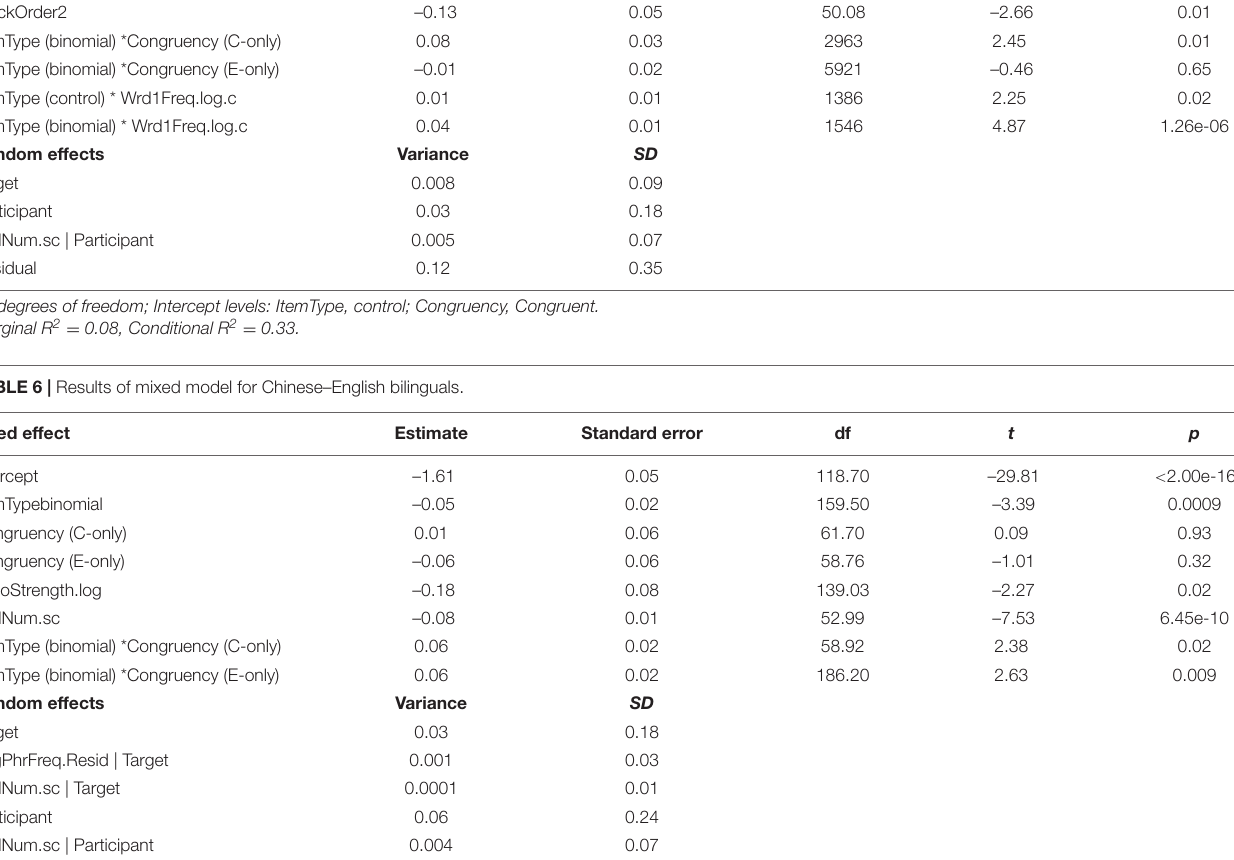
Table 6 for Chinese–English bilinguals, and Table 7 for English– Chinese